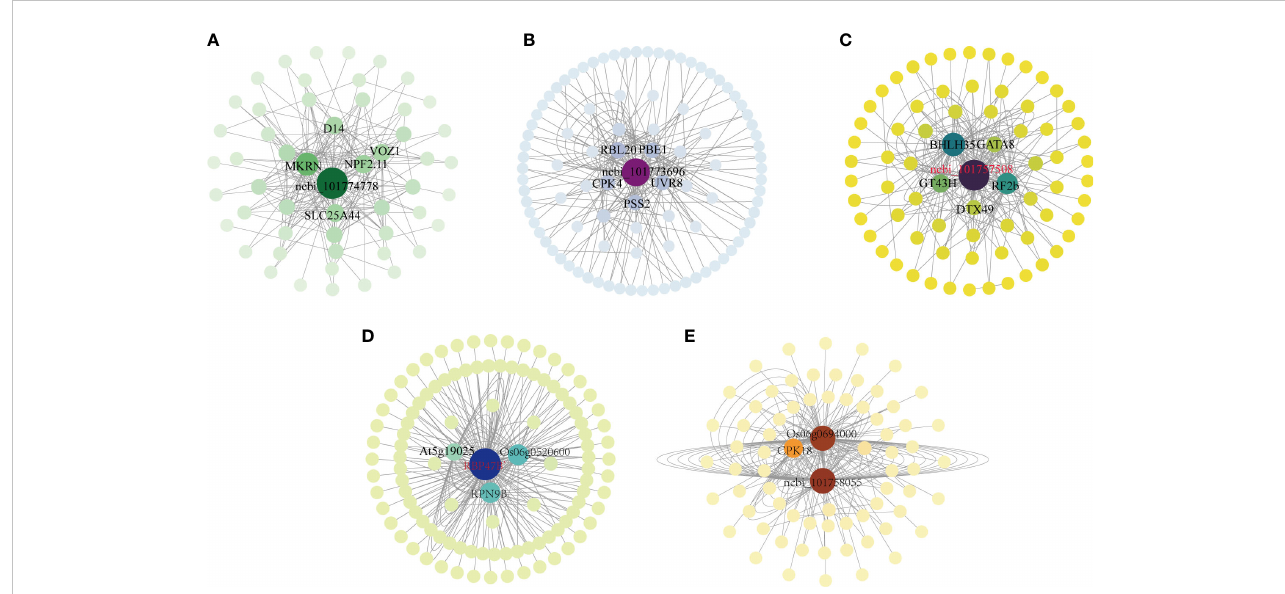
FIGURE 6 Co-expression regulatory network analysis of fi ve key co-expression modules. (A) Co-expression regulatory network analysis of the MM06 module; (B) Co-expression regulatory network analysis of the MM13 module; (C) Co-expression regulatory network analysis of the MM14 module; (D) Co-expression regulatory network analysis of the MM04 module; (E) Co-expression regulatory network analysis of the MM06 module.